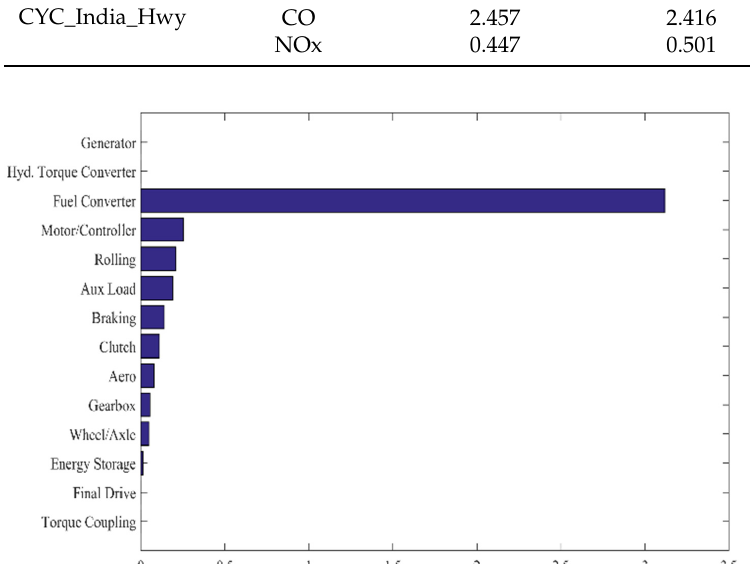
Figure 9. Pollutant emission comparison.